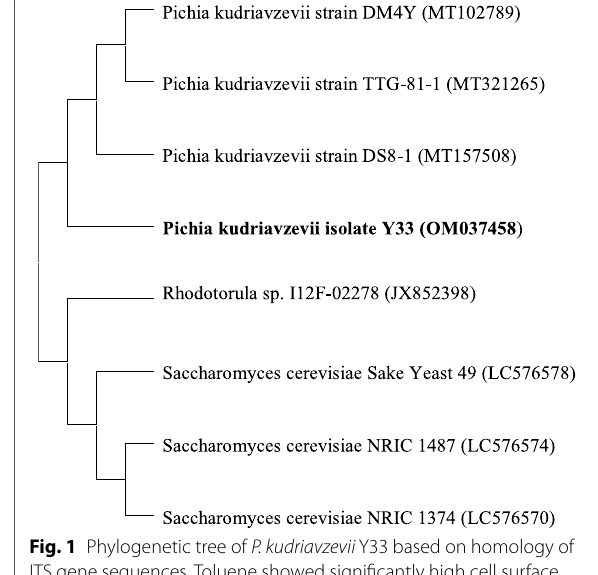
standard deviation (SD) of triplicate analysis, - no zone of inhibition ±